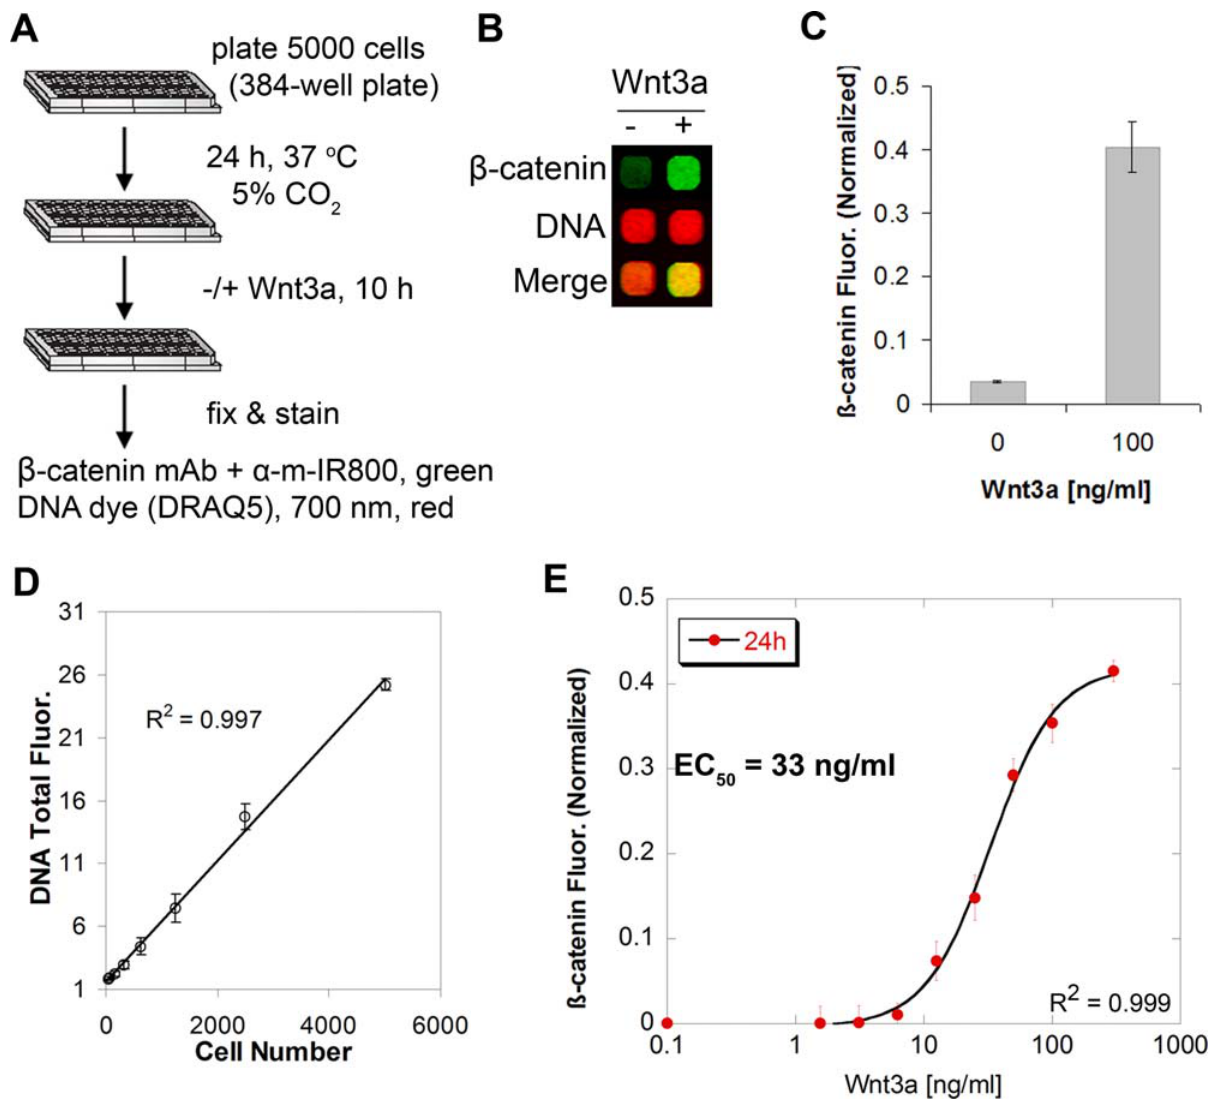
Figure 1. Description and validation of a quantitative method for temporal detection of cellular b -catenin. (A) Schematic of the assay. m denotes mouse species. (B) A representative output infrared image of L-cells treated with or without Wnt3a (100 ng/ml) for 10 h. The image shows whole-cell fluorescence from actual wells of a 384-well plate, highlighting increase in b -catenin signal (green, 700 nm) without change in cellular DNA content (red, 800 nm, detected by DRAQ5). (C) Quantification of the b -catenin signal from (B). The signal is background subtracted and normalized to DNA fluorescence. Values represent the mean 6 SEM from quadruplicate experiments. (D) Linearity of measured DNA fluorescence (DRAQ5 signal) versus actual number of L-cells plated per well. (E) Dose titration of Wnt3a at 24 h illustrating half-maximal activation of cellular b -catenin in L-cells occurs at 33 ng/ml ligand.